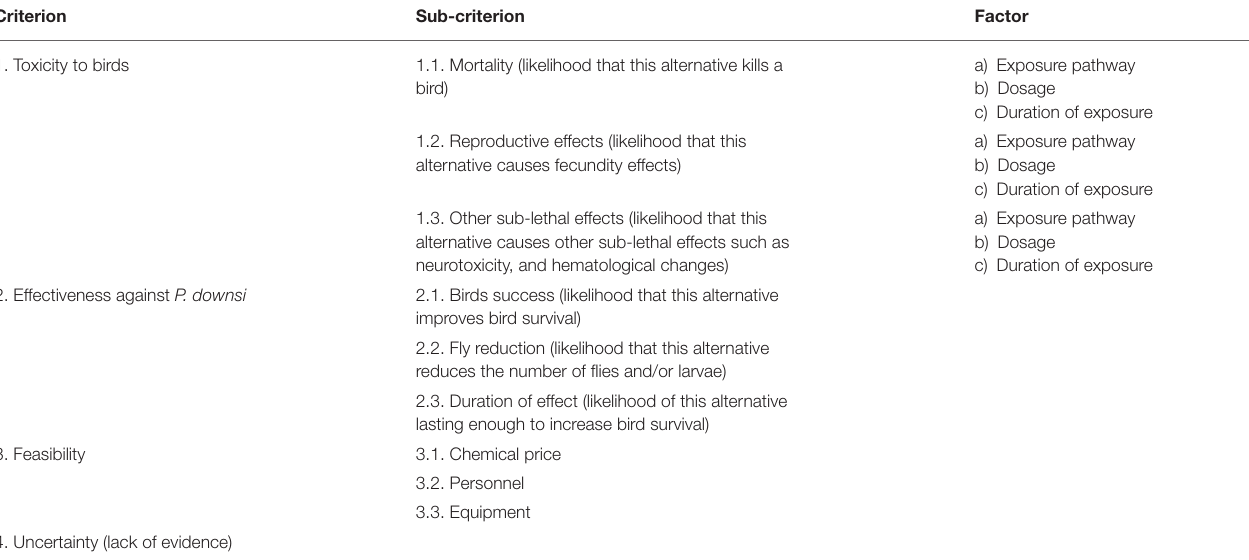
TABLE 2 | Criteria, sub-criteria, and factors considered to evaluate the six alternatives in the risk assessment model. Criterion